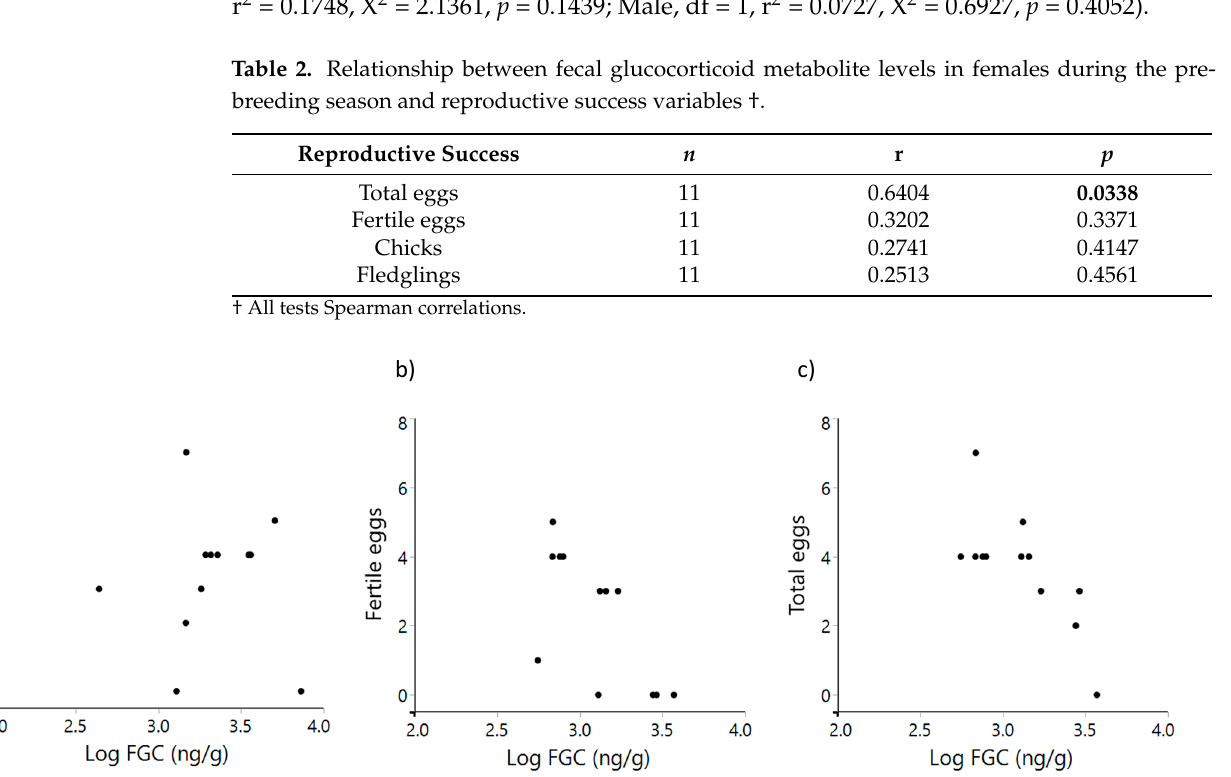
Figure 2. Significant relationships of fecal glucocorticoid metabolites to reproductive success measures. ( a ) Females showed a positive relationship of fecal glucocorticoid metabolites during the pre-breeding to the total eggs laid by female in the following breeding season (2018). Males have a negative relationship of fecal glucocorticoid metabolites to ( b ) total eggs and ( c ) total fertile eggs laid in the following breeding season (2018).